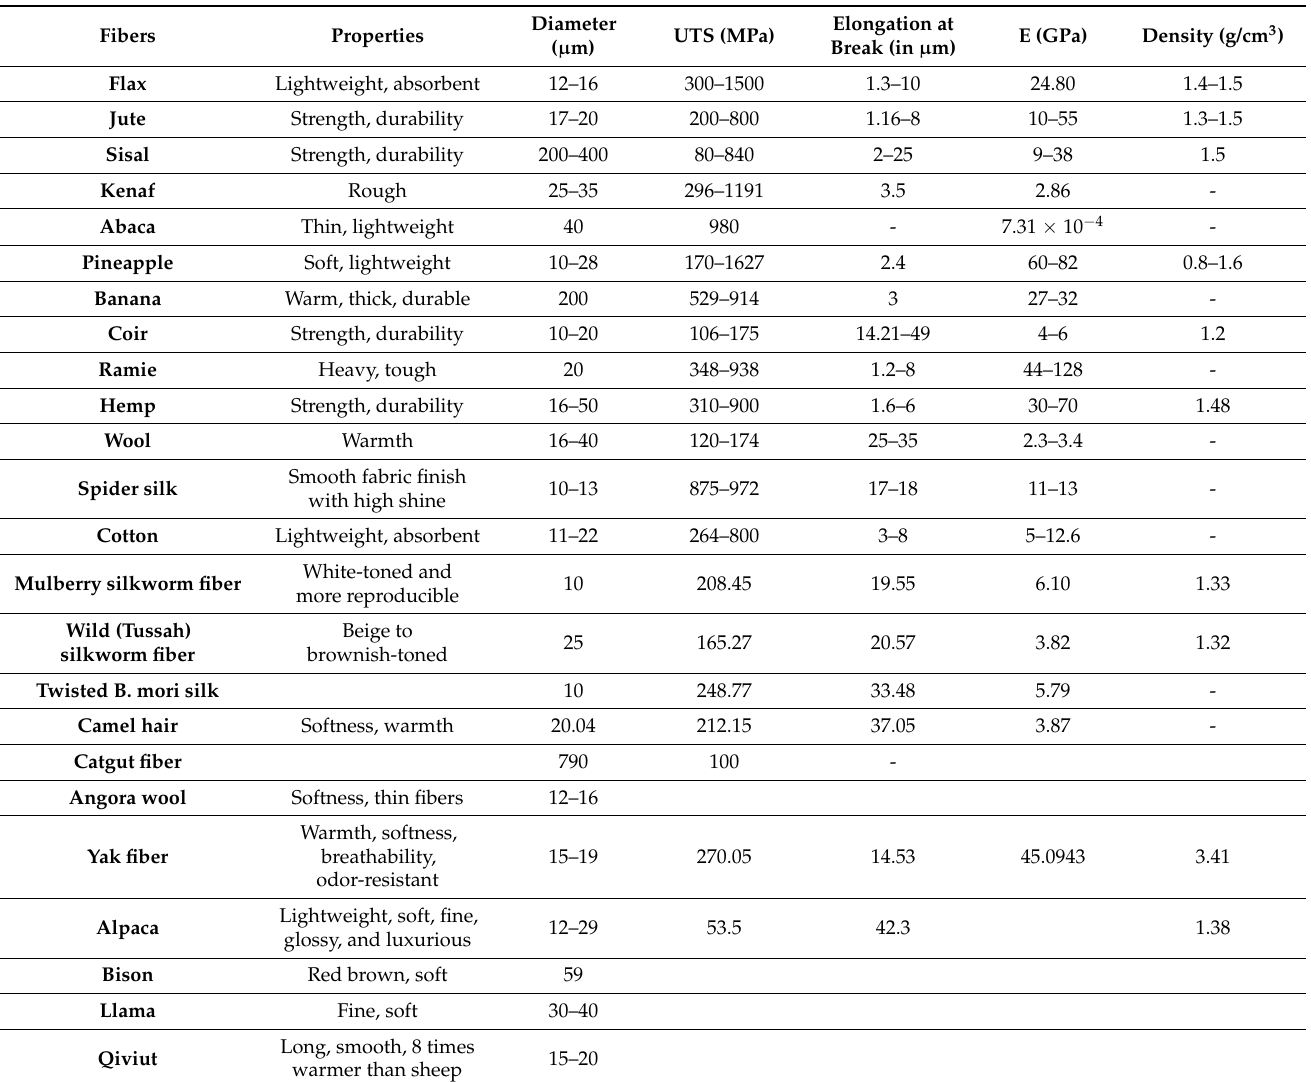
Table 1. Demonstration of the different properties of natural fibers derived from plants and animals